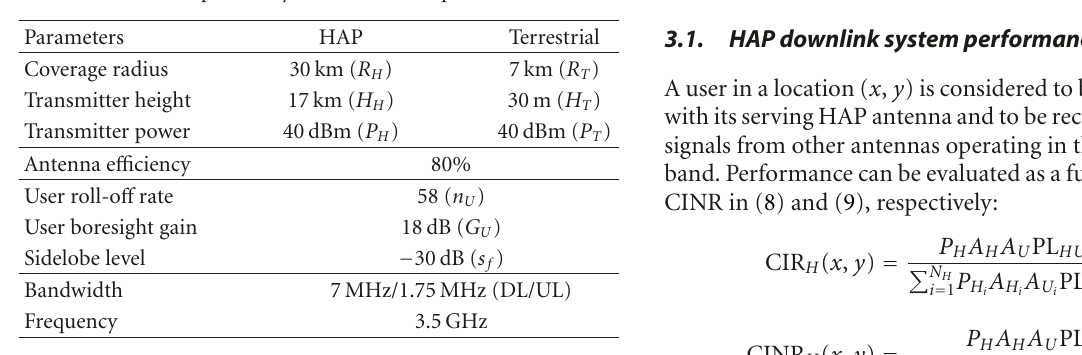
Table 1: Important system simulation